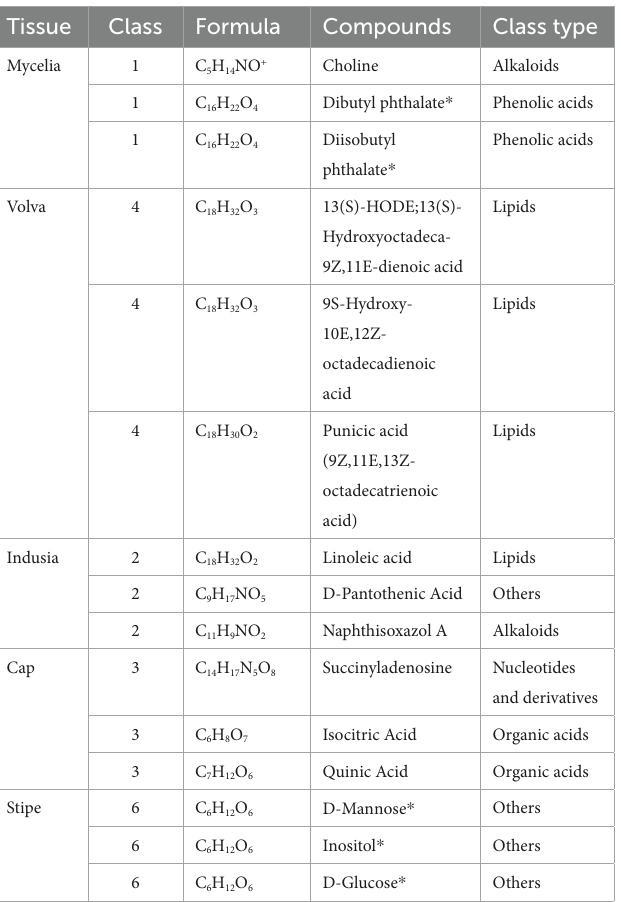
TABLE 3 Top three metabolites in the DI tissues.